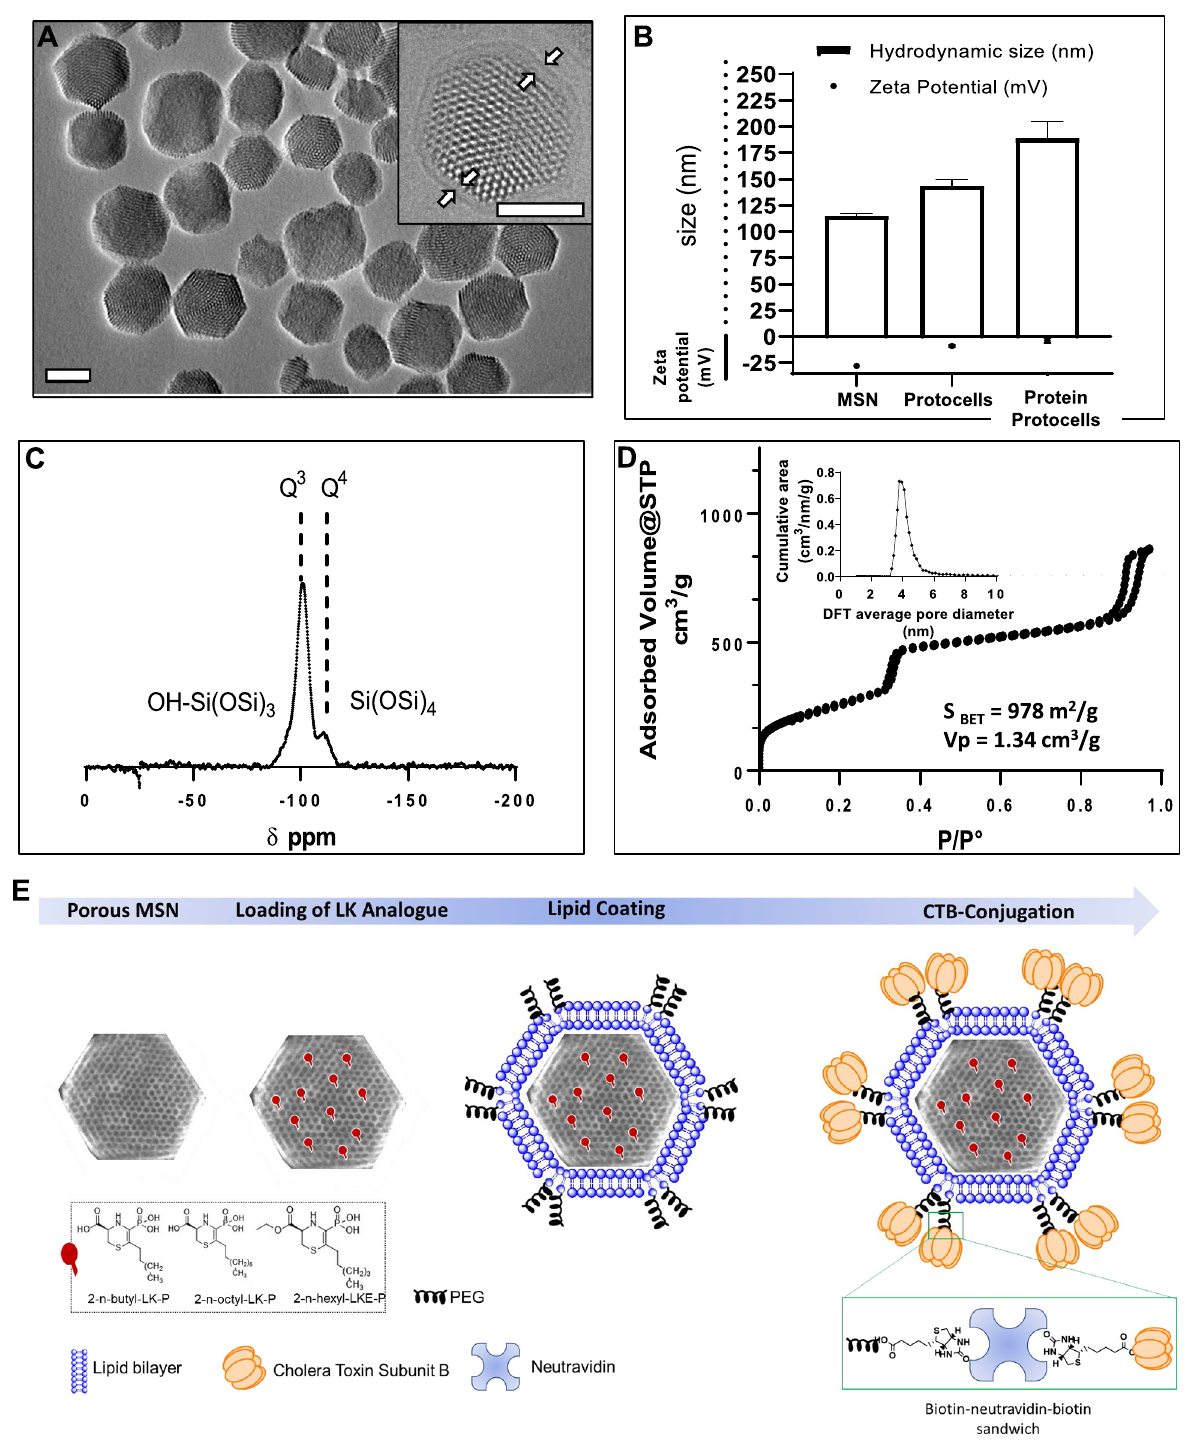
Figure 2. ( A ) Transmission electron microscopy image of mesoporous silica nanoparticles (MSN), inset shows a lipid-coated nanoparticle where lipid shell is indicated by white arrows. Bar, 50 nm. ( B ) Hydrodynamic diameter measured by dynamic light scattering and zeta potential. ( C ) Solid state 29Si CP-MAS NMR showing only Q4 (− 110 ppm) and Q3 (− 100 ppm) species ( D ) N2 sorption isotherm and corresponding pore volume and surface area at standard temperature and pressure (STP). ( E ) General schematic of the protocell preparation procedure. All reported values correspond to the average of at least three independent